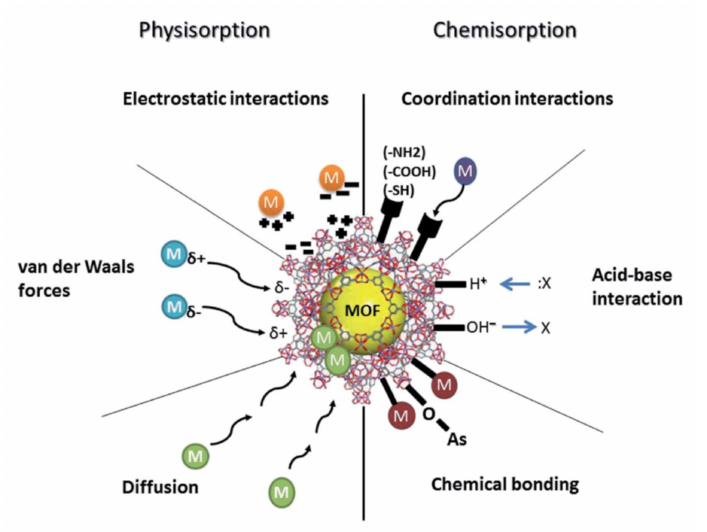
Figure 9. Different physisorption and chemisorption interactions of MOFs with organic and inorganic pollutants in aqueous media. Reprinted with permission from